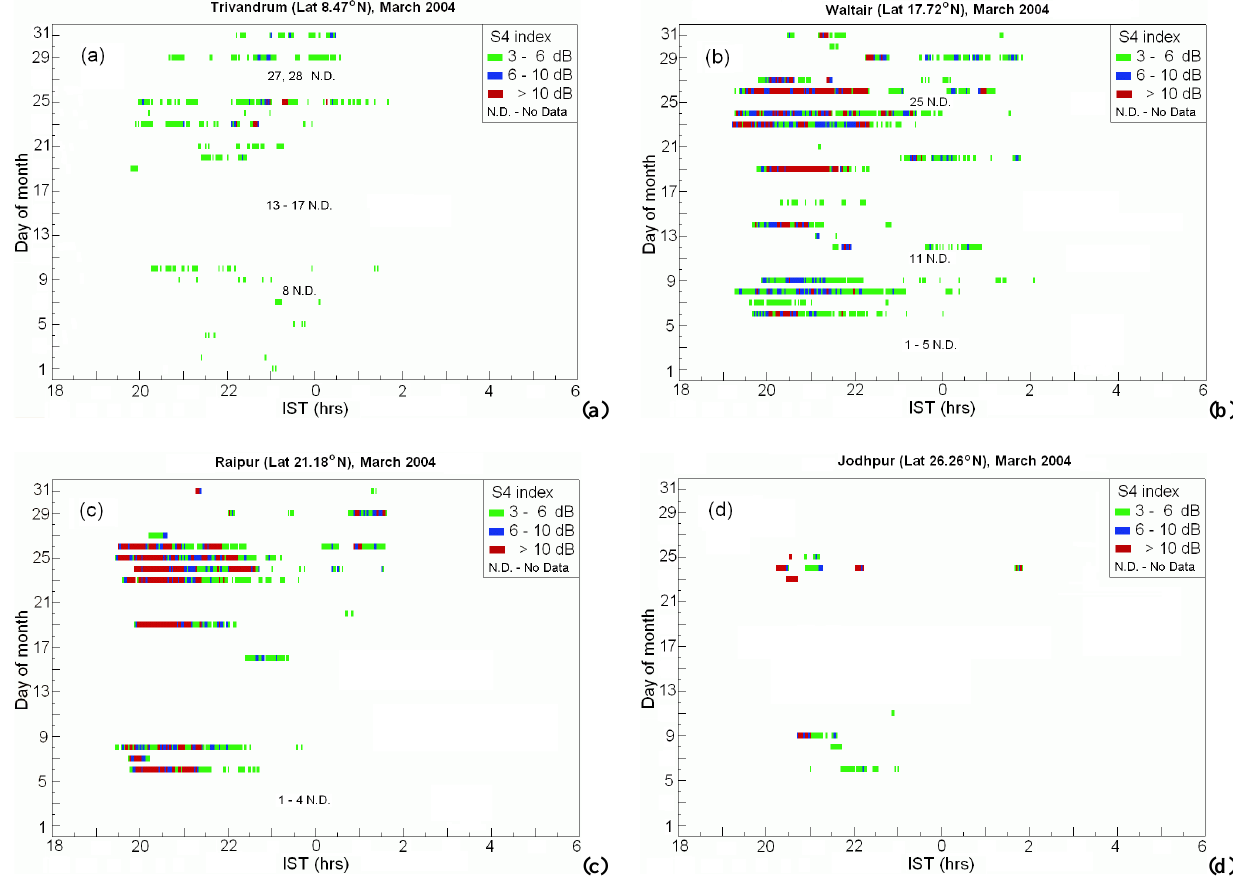
Fig. 2. Day-to-day occurrence of scintillations at different power levels during the month of March 2004 at four typical Indian latitudes representing an (a) equatorial station (Trivandrum), (b) low-latitude station (Waltair), (c) anomaly crest station (Raipur), (d) station beyond the anomaly crest